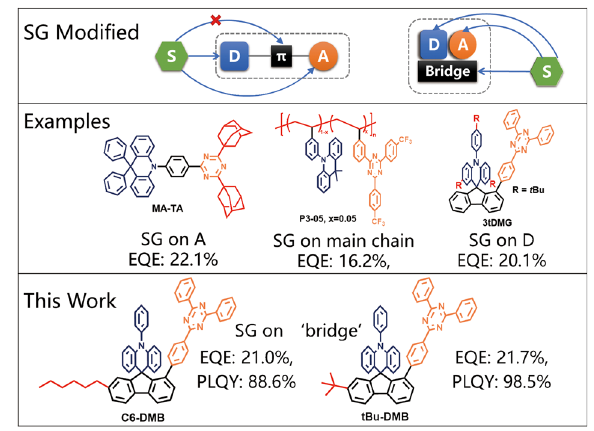
Fig. 1 Illustration for design strategy of the solubilizing groups (SG) functionalized TADF emitters 19,21,24 . Upper: design strategy; middle: examples for the introduction of SGs; bottom: the molecular structures in this work.